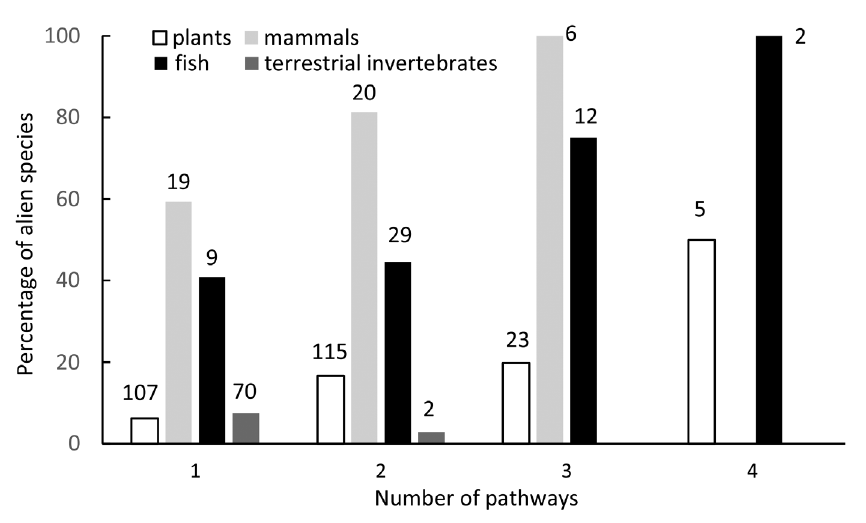
Figure 1. Percentage of alien species with impact in relation to the number of introduction pathways. The height of the bar indicates the percentage of the number of taxa with impact within the taxonomic group of species that are introduced via the given number of pathways. Numbers above bars indicate the numbers of species with impact for each taxonomic group and for the given number of